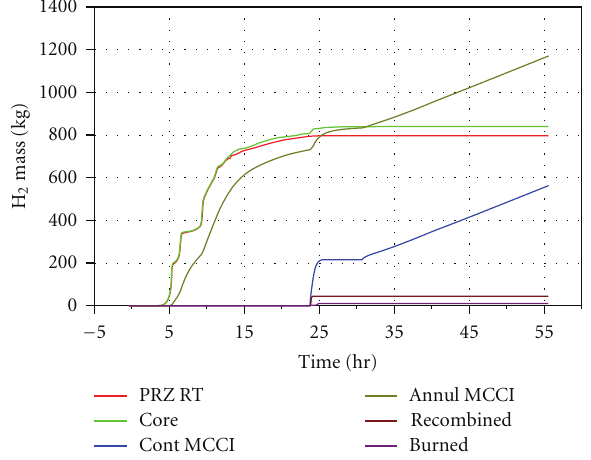
Figure 23: Hydrogen mass generated in core and from MCCI in containment, released from leak and recombined by